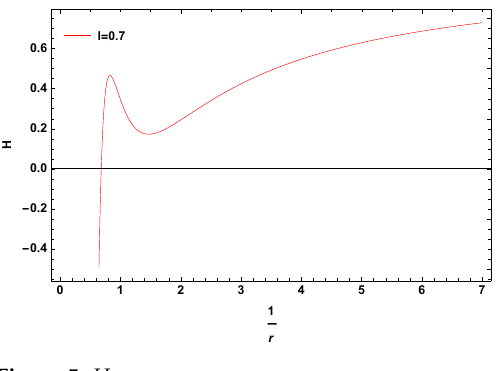
Figure 1: H versus r . 189 Figure 5. H versus r